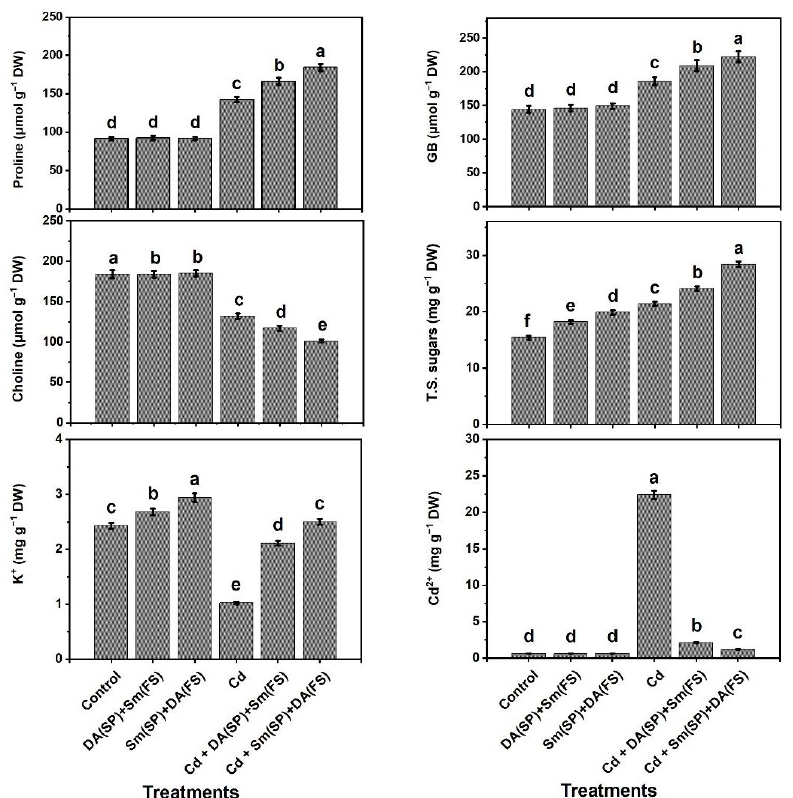
Figure 2. Effects of seed priming (SP) and foliar spraying (FS) with silymarin (Sm) or dopamine (DA) on osmoprotectants and cadmium contents of cadmium-stressed Phaseolus vulgaris plants. Columns labeled with same or different letters within each plot signify non-significant or significant differences, respectively, based on LSD test ( p ≤ 0.05). Bars represent SE values (three replicates). GB = Glycine betaine, T.S. sugars = Total soluble sugars, K + = Potassium ion, and Cd 2+ = Cadmium ion. Plant water status was measured as relative content of water (RWC %), stability index of membranes (MSI %), and leakage of ions (EL %) (Figure 3). Under cadmium stress con- ditions, the RWC and MSI were noticeably decreased by 48.9 and 47.2 %, while the EL was increased by 309.5 %. Both Sm or DA exogenous application (DA (SP) + Sm (FS)) and (Sm (SP) + DA (FS)) considerably raised the RWC and MSI and also considerably dimin-